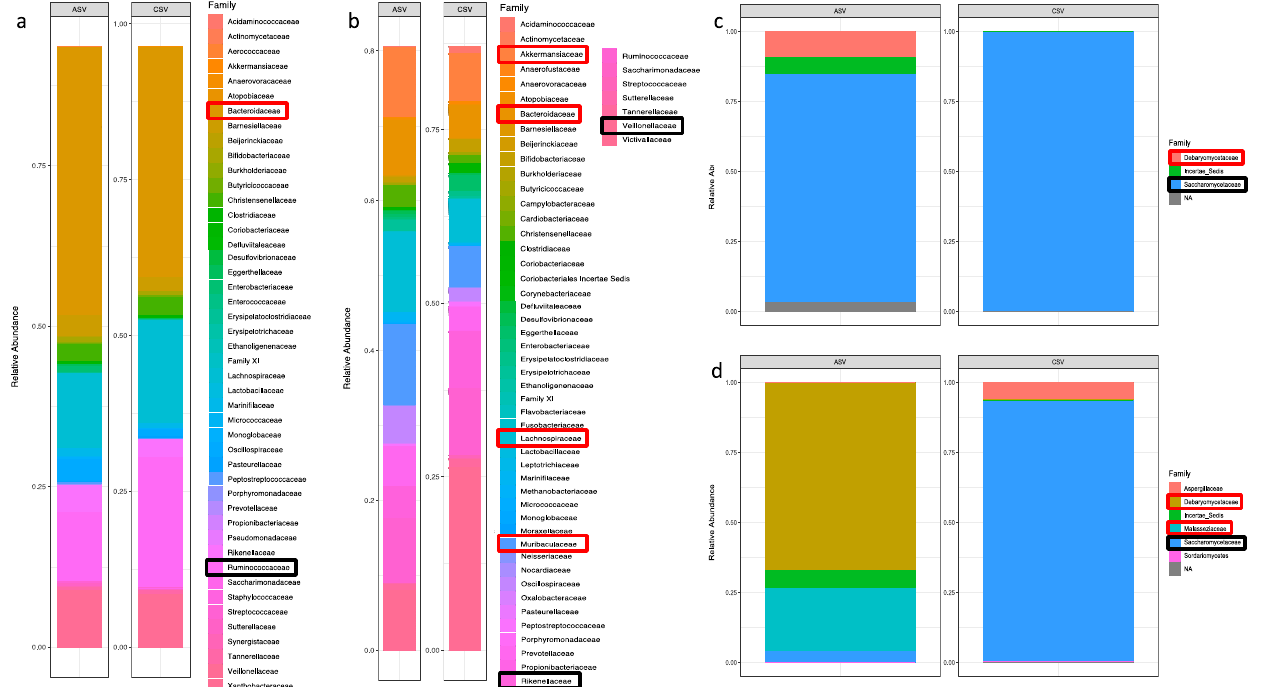
Figure 6. Microorganism composition of the couples of siblings. Microbiota composition, expressed as abundance fractions, in couple #1 ( a ) and in couple #2 ( b ); Mycobiota in ( c ) for couple #1 and in ( d ) couple #2. Families are red squared if increased in ASD sample and black squared if decreased.